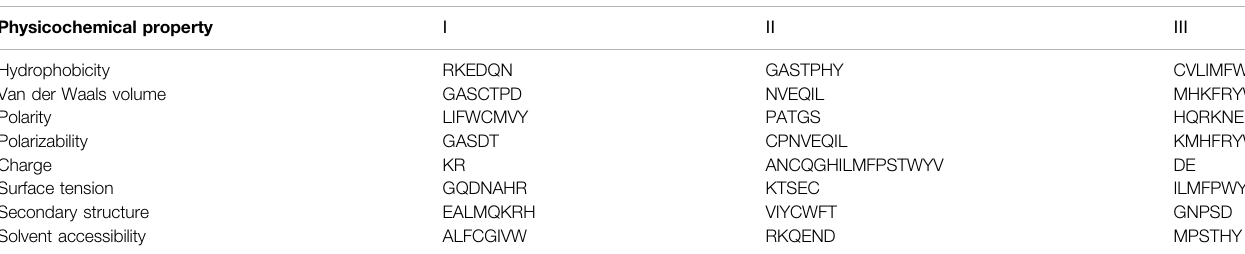
TABLE 4 | List of the 3 categories divided according to the physical and chemical properties of proteins. Physicochemical